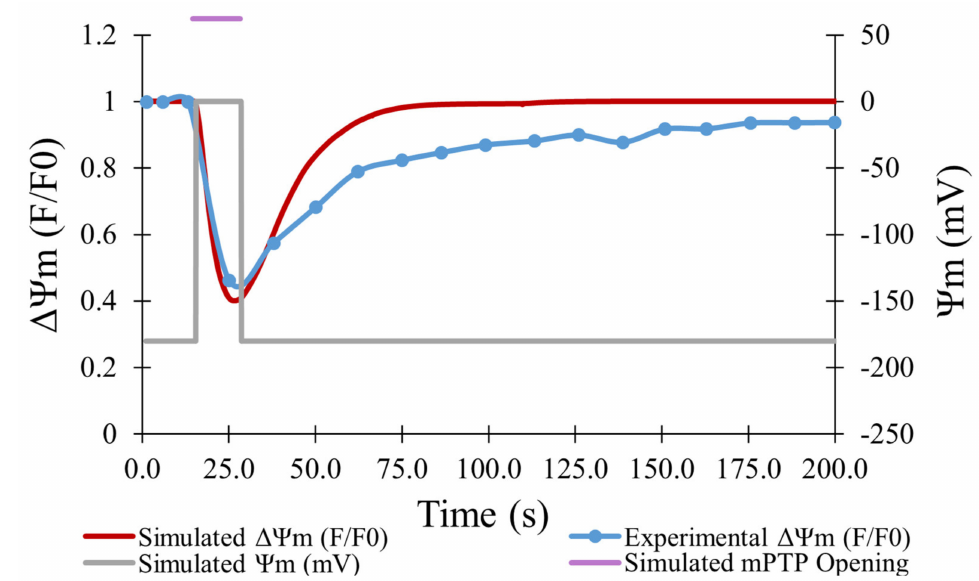
Figure 4. Average change in TMRM fluorescence (F/F0) over time for transient opening events. Experimental TMRM fluorescence for 478 transient opening events (blue) [7]. Model fit to data with 500 transient opening events (red). Mitochondrial membrane potential during an average transient opening event (gray—right axis) was assumed to exactly follow the timing and duration of an average transient opening event. Figure 5A is a histogram of the amplitude distribution of transient opening